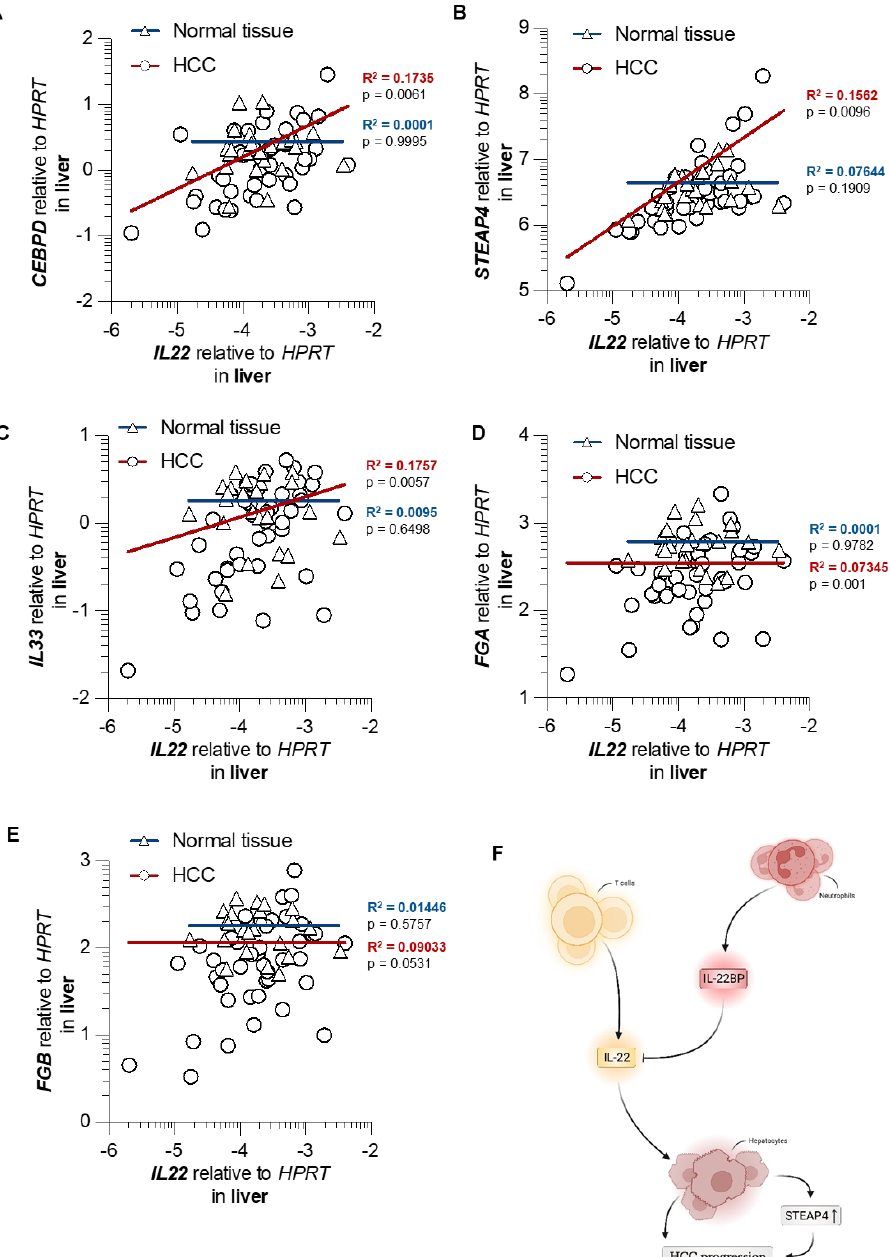
Figure 6. IL22 expression is associated with the expression of CEBPD , STEAP4 , and IL33 in HCC but not in healthy livers. ( A ) correlation of relative expression of IL22 and CEBPD in comparison to HPRT in liver samples with HCC (red, n = 42) and in normal liver tissue (blue, n = 24); ( B ) correlation of relative expression of IL22 and STEAP4 in comparison to HPRT in liver samples with HCC (red, n = 42) and in normal liver tissue (blue, n = 24); ( C ) correlation of relative expression of IL22 and IL33 in comparison to HPRT in liver samples with HCC (red, n = 42) and in normal liver tissue (blue, n = 24); ( D ) correlation of relative expression of IL22 and FGA in comparison to HPRT in liver samples with HCC (red, n = 42) and in normal liver tissue (blue, n = 24). ( E ) correlation of relative expression of IL22 and FGB in comparison to HPRT in liver samples with HCC (red, n = 42) and in normal liver tissue (blue, n = 24). Displayed are all samples with detectable IL22 expression from 60 samples analyzed of HCC and 37 samples analyzed of healthy livers. Each data point represents one patient sample. ( F ) graphical representation depicting the role of the IL-22 − IL-22BP axis in HCC.